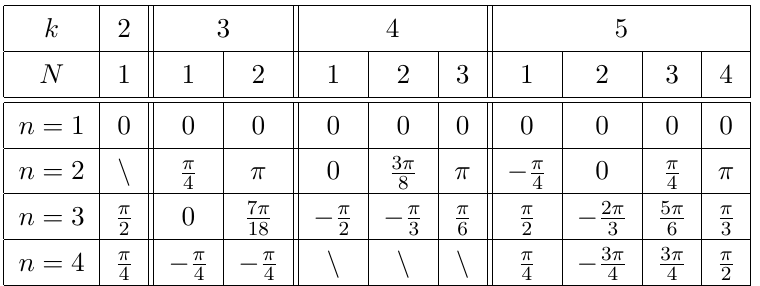
Table 4 . The exact values of the phases of e iθ ( N,k ) ˜ Z